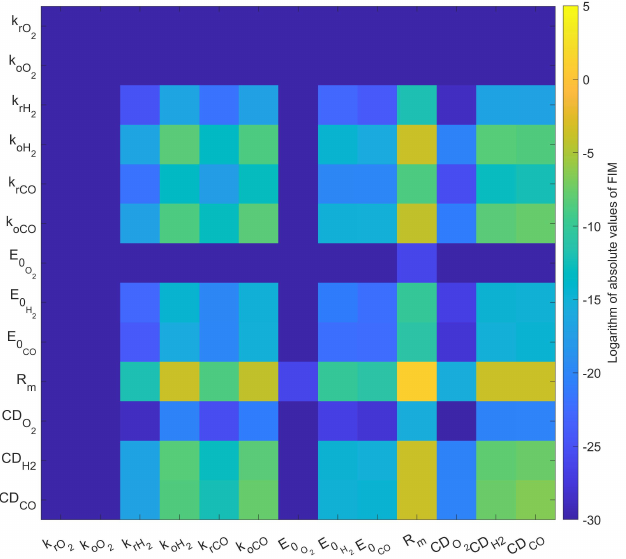
Figure 2. The logarithm of the absolute values of the FIM obtained for the model calibrated on the full experimental data